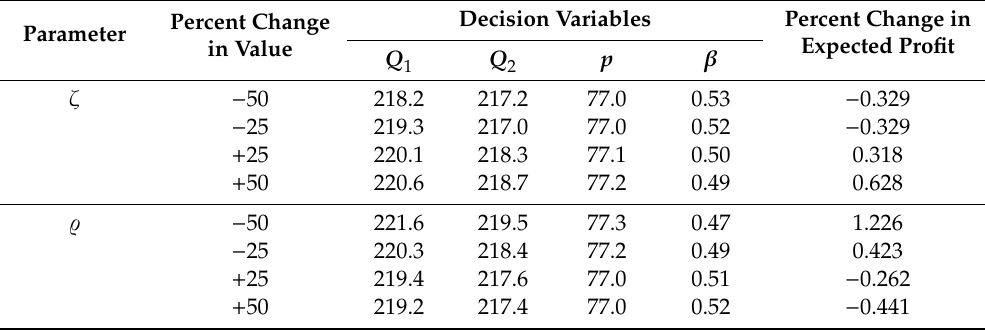
Table 4. Sensitivity analysis for the key discounted sales